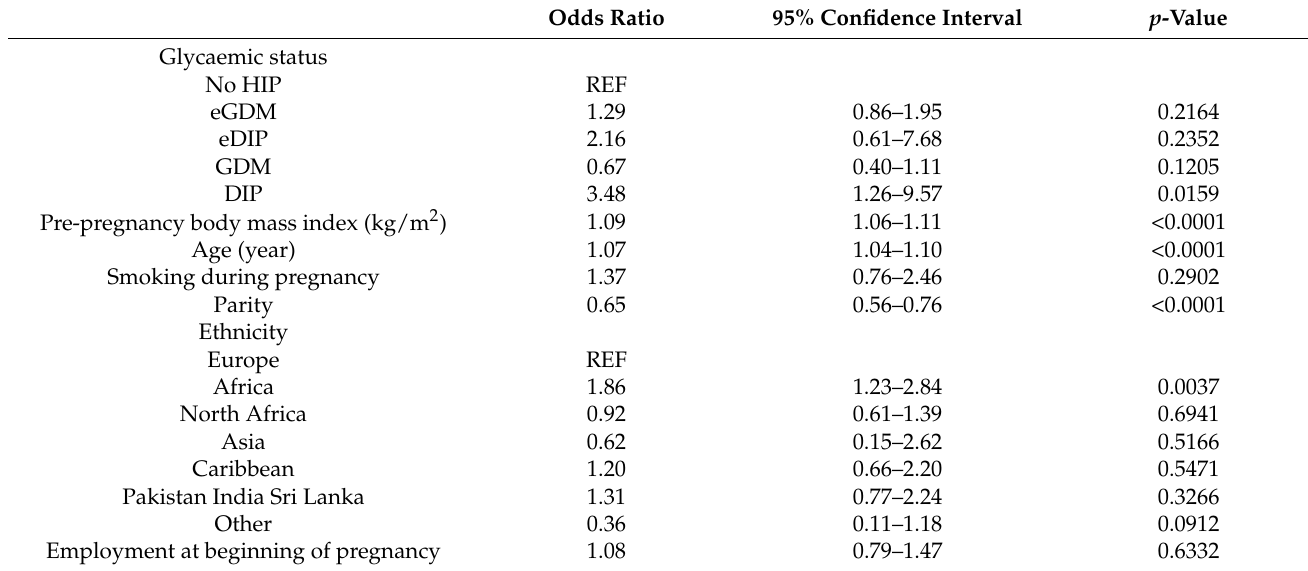
Table 2. Determinants of hypertensive disorders in multivariable analysis.